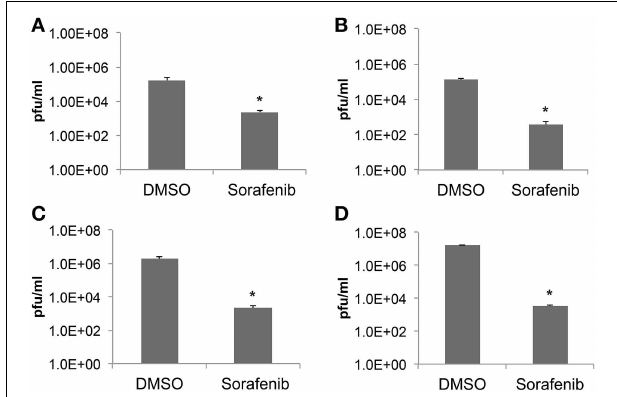
FIGURE 2 | Sorafenib reduces RVFV replication in multiple cell types. (A) Vero, (B) HSAEC, (C) Huh7 cells infected with rMP12 (MOI 0.1) or (D) Vero cells infected with BSL-3 RVFV strain rZH548 (MOI 0.1) were incubated with either DMSO or sorafenib as described above ( Figure 1 ). Media supernatants were collected 24 hpi and infectious viral titers analyzed by plaque assay. The average and standard deviation of three biological replicates are plotted. * p ≤ 0 . 01 .